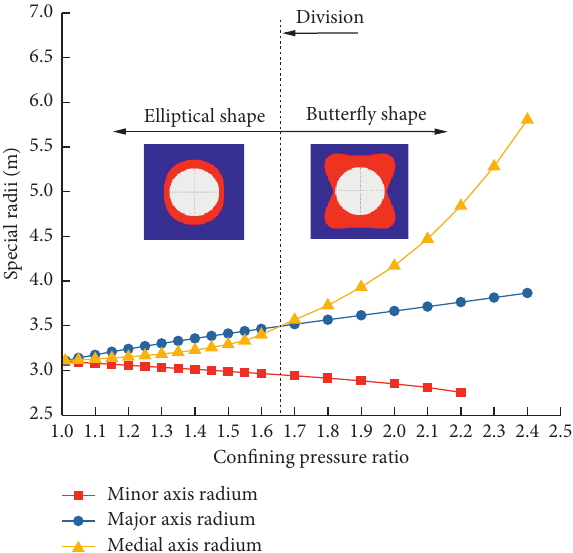
Figure 12: Radius variation curves at different positions and the division between plastic area